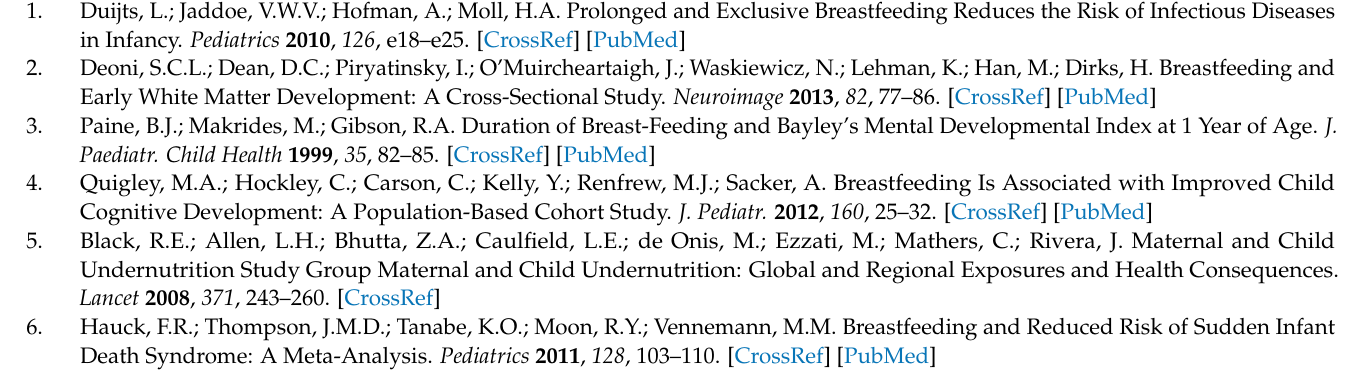
Table S3: Linear mixed models with random effect associated with macronutrients and antioxidants of the breast milk without interaction